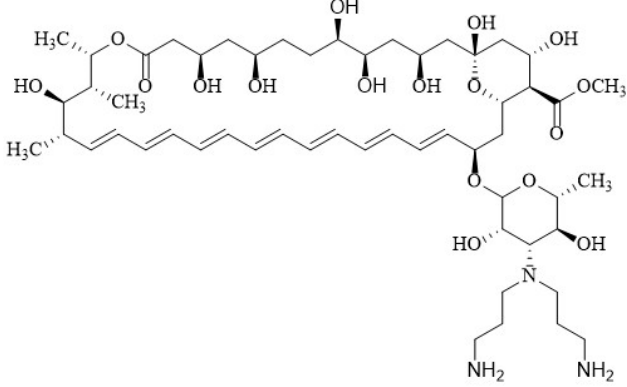
Figure 8. The N , N -di-(3-aminopropyl) AmB derivative 5 .